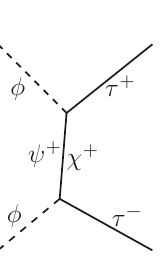
Figure 10 . DM indirect search channel. Dark fermions appear in the propagator, facilitating the mixing